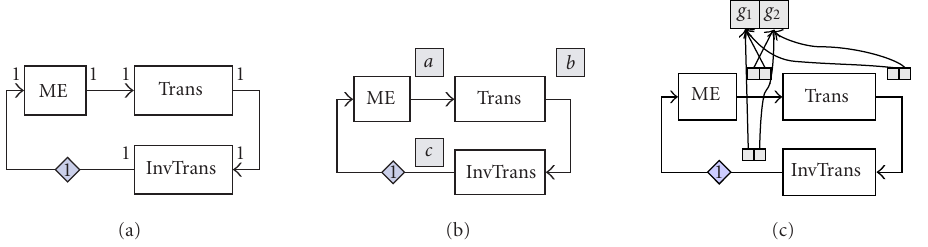
Figure 3: (a) Simplified H.263 encoder in which a diamond between InvTrans and ME indicates an initial sample delay, (b) and (c) a minimum bu ff er allocation without and with separation of global bu ff ers and local bu ff ers, respectively.